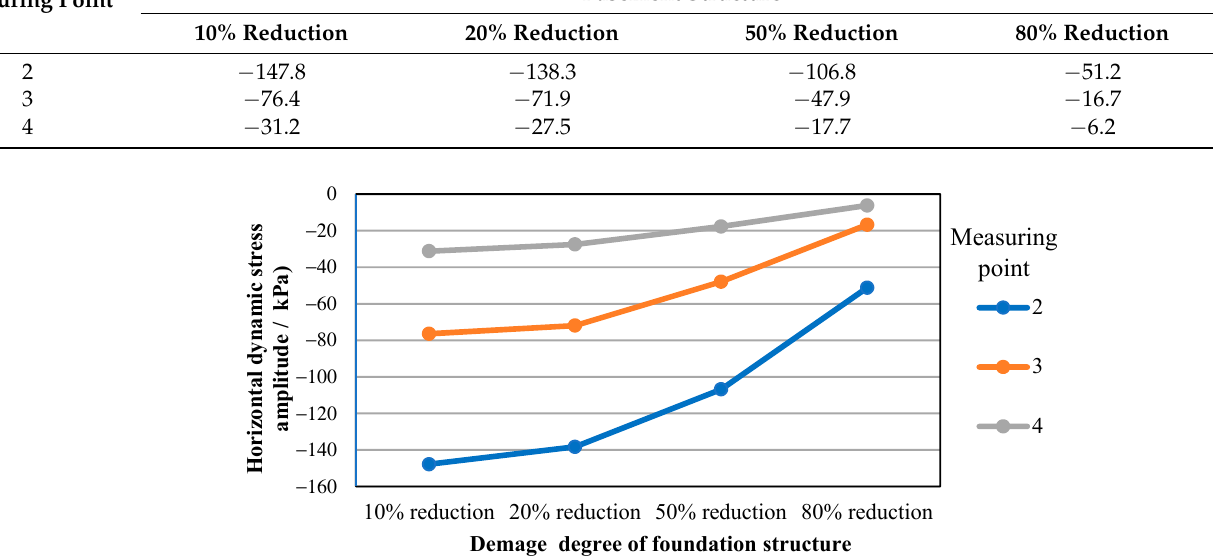
Figure 11. Horizontal dynamic stress amplitudes diagram of measuring points 2, 3, and 4 under different degrees of damage to the foundation structure.